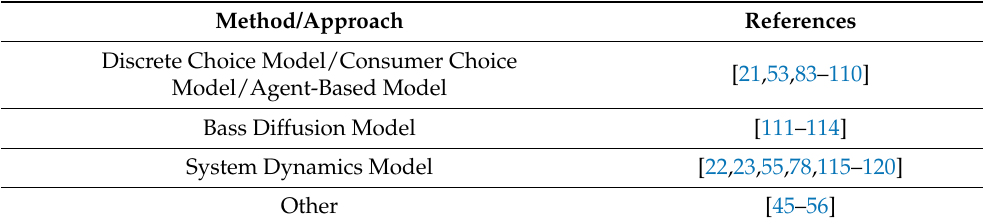
Table 1. Prior literature and methods used to forecast Electric Technology Vehicle (ETV) adop-